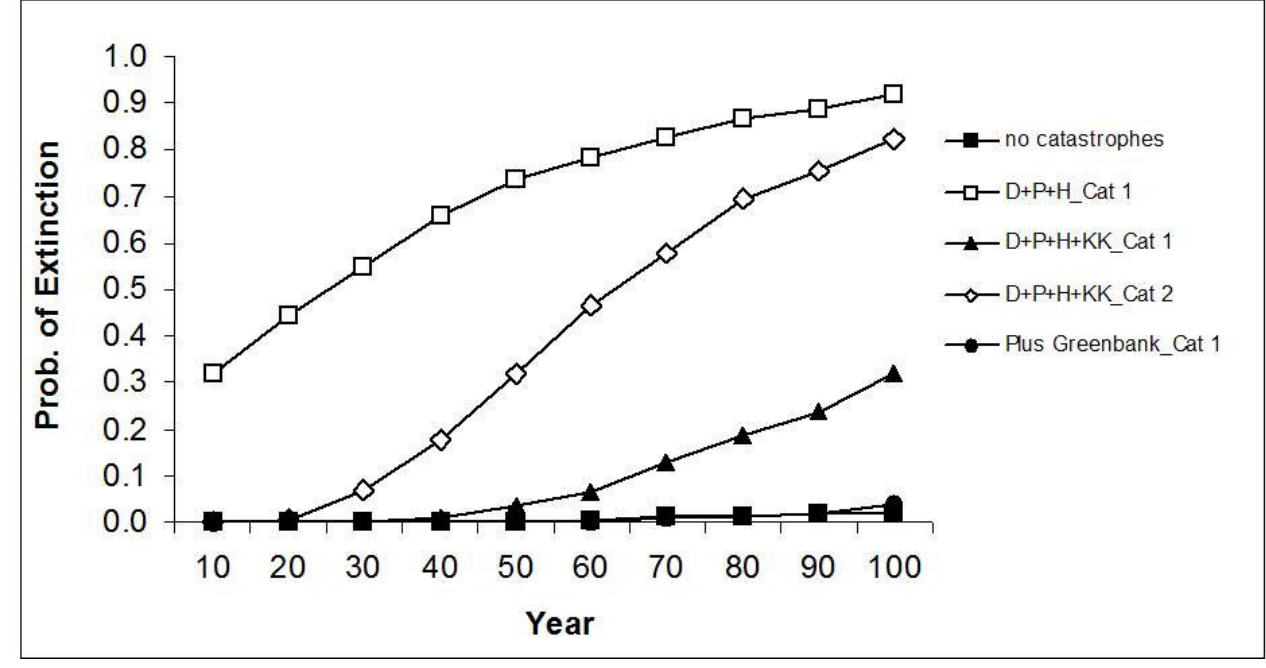
Fig. 6. Probability of extinction for the greater glider metapopulation with (cat. 1 or 2) and without (no catastrophes) the inclusion of catastrophes (refer Fig. 4) for different combinations of remnants or for all remnants (Plus Greenbank). Drewvale (D), Parkinson (P), Heathwood (H), Karawatha–Kuraby